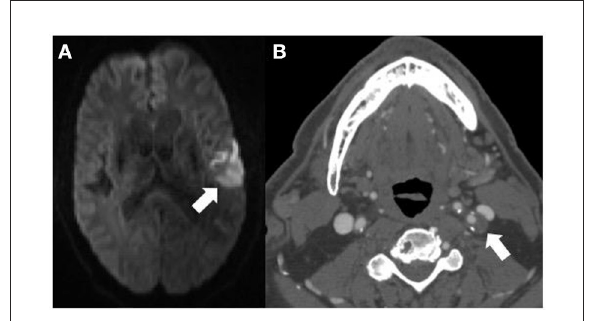
FIGURE2 This 71-years-old patient presenting with an acute left middle cerebral artery territory infarction [arrow (A) ] did not have any significant stenosis by North American Symptomatic Carotid Endarterectomy Trial criteria on CT angiography (CTA) and was thought to have an embolic stroke of undetermined source. The CTA (B) does however show a large, predominantly non–calcified plaque up to 5mm in thickness in the proximal left internal carotid artery [ (B) arrow] compatible with a vulnerable plaque, potentially the embolic source of the